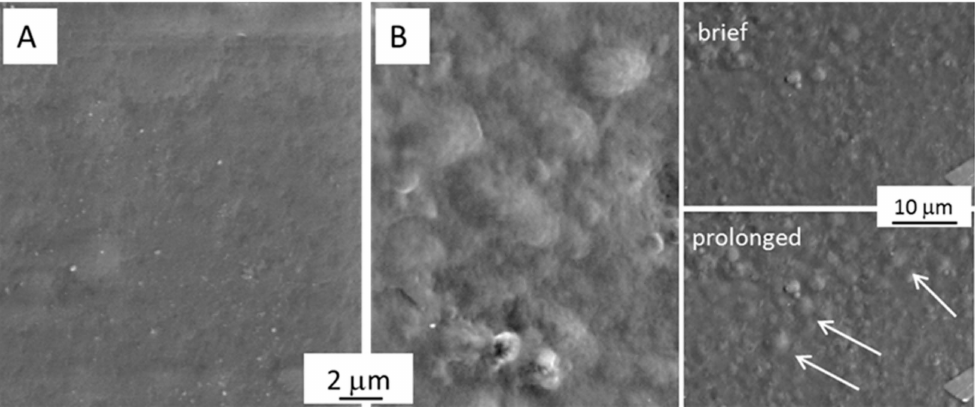
Figure 1. SEM micrographs showing the surface of ( A ) F-Alg / Chito and ( B ) F-Alg / Chito / BBS. The inset in section B reports the aspect of the surface after brief (few seconds) and prolonged (ca. 1 min) exposure to the electron beam (the arrows evidence the defects formed during the